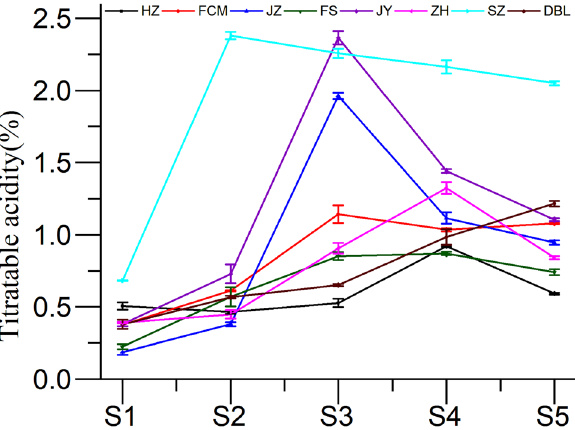
Figure 3. Change in titratable acid content of jujube fruit at various developmental stages.